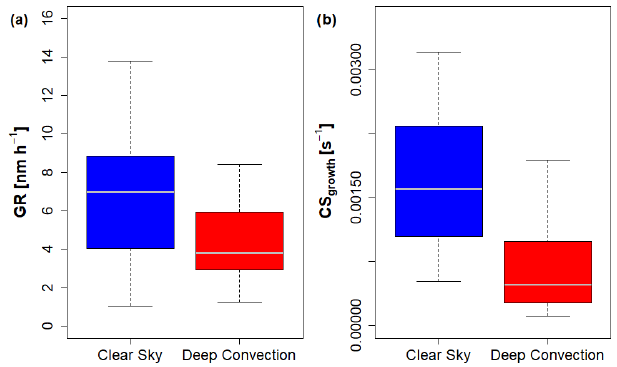
Figure 11. Box plot of (a) GR and (b) CS growth for clear-sky con- ditions (Tir > 281K) vs. deep-convection conditions (Tir < 228K). Boxes represent the quartiles, whiskers represent 90th and 10th per- centiles, and the horizontal line represents the